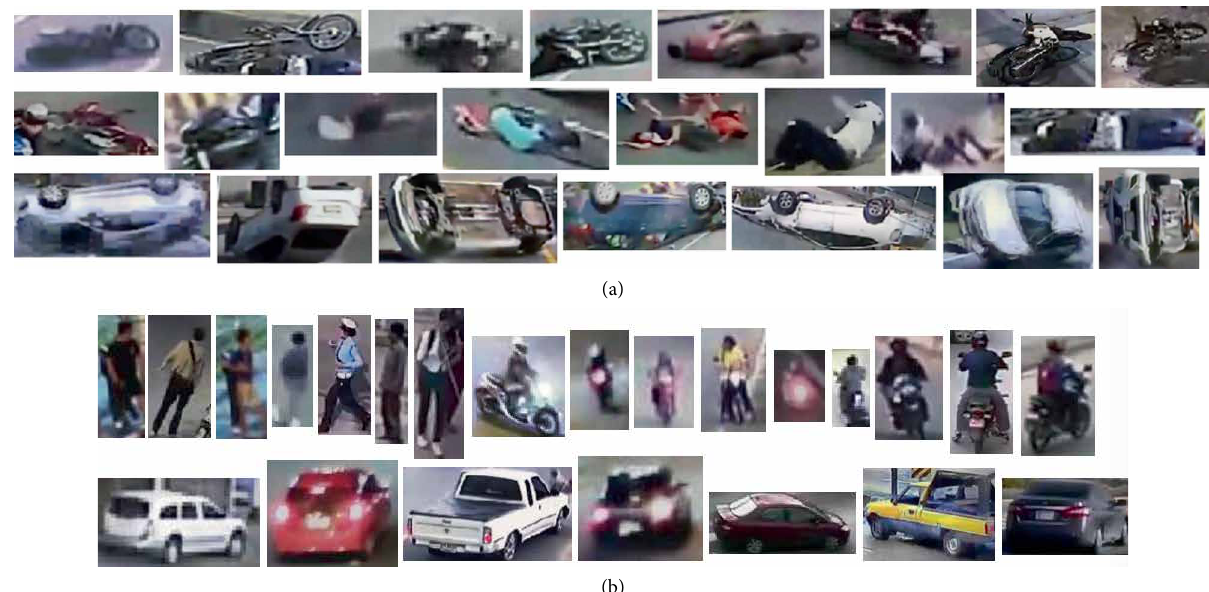
Figure 6: Training samples of Yolo v3. (a) Crash samples and (b) normal samples.